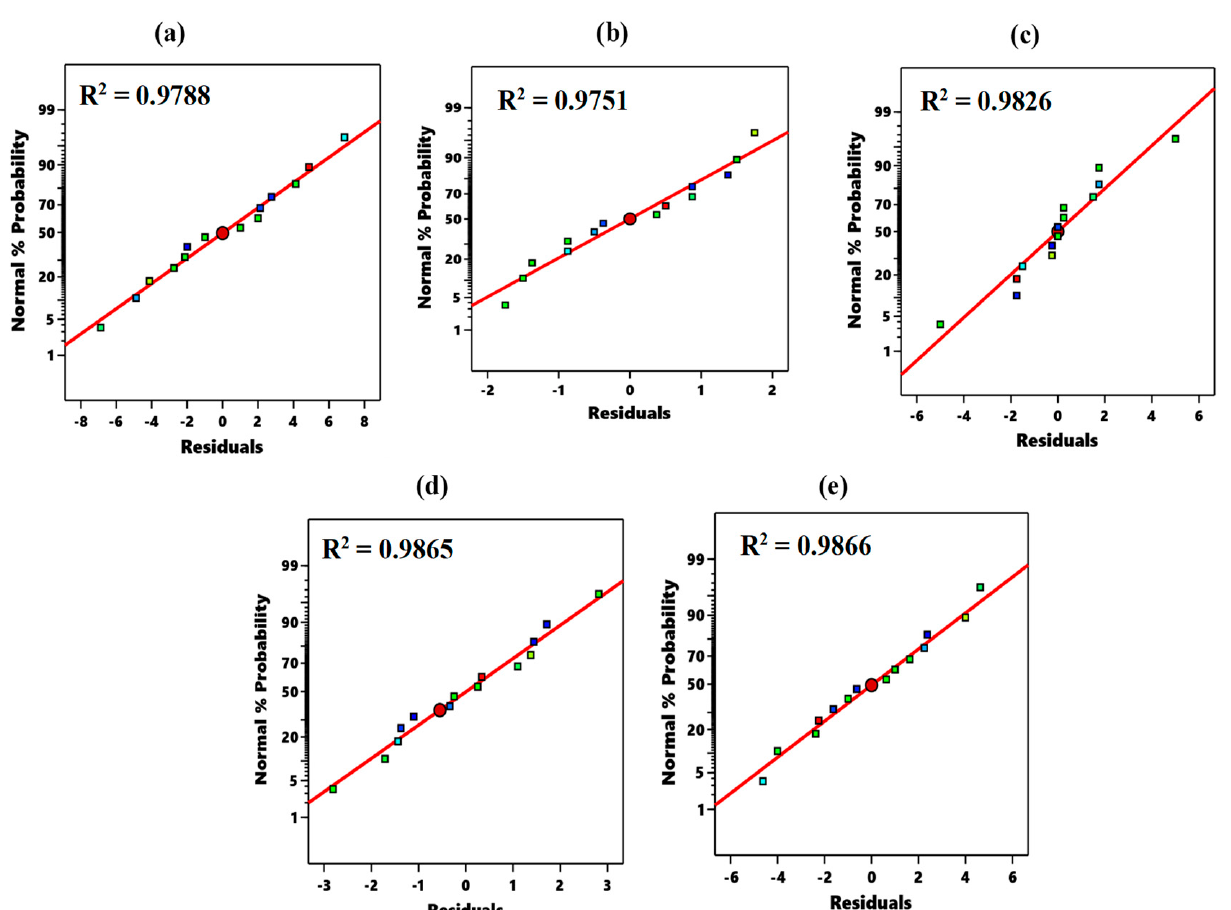
Figure 7. Normal probability plot for responses ( a ) tensile strength, ( b ) tensile modulus, ( c ) compressive strength, ( d ) compressive modulus, and ( e ) flexural strength.